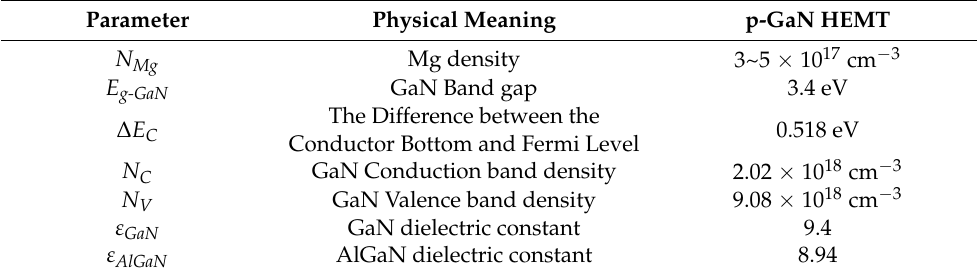
Figure 1. Transmission electron microscope ( TEM) picture of the Schottky metal/p-GaN gate AlGaN/GaN high electron mobility transistors (HEMT). Table 1. Main material properties in p-GaN gate HEMT.